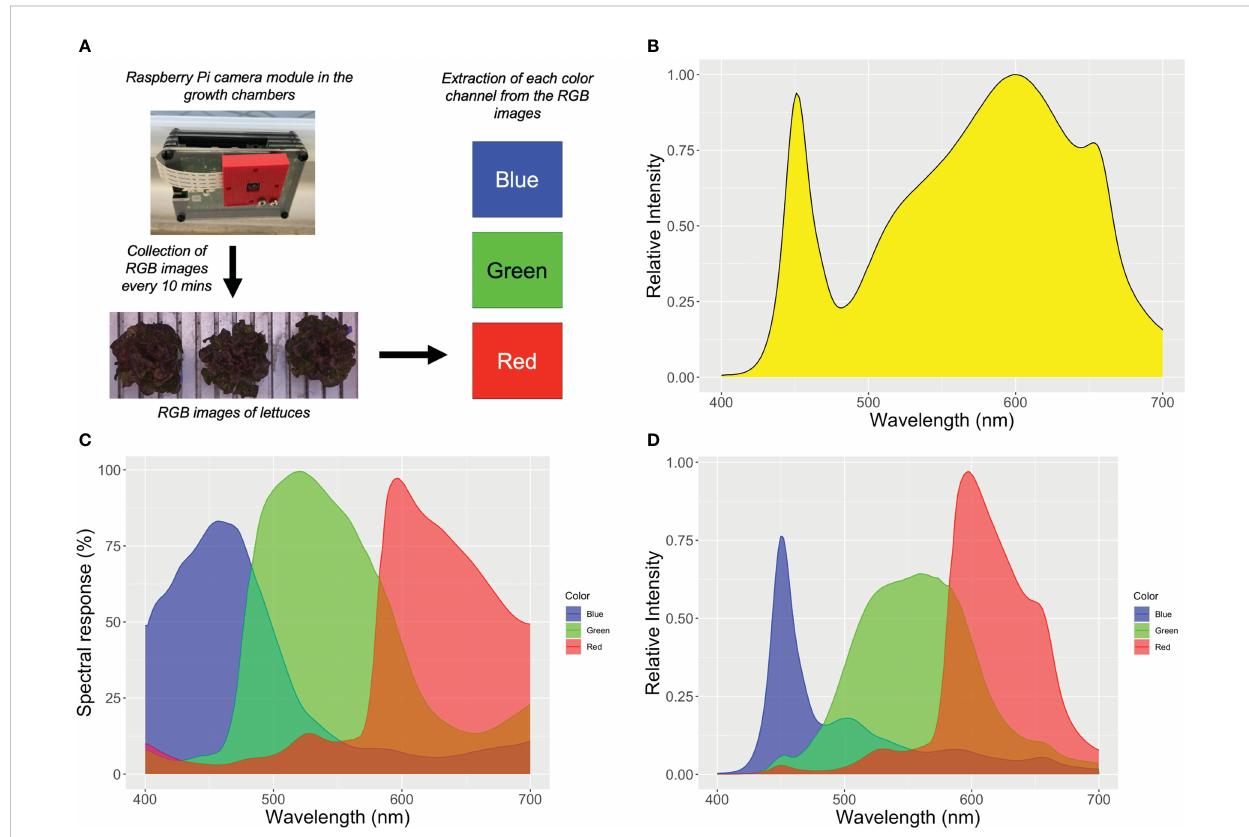
FIGURE 2 Schematic representation of acquisition process of green and red spectral images by the Raspberry Pi Camera Module V2.1 (A) , the normalized spectrum of the warm-white LED light fi xtures in the growth chambers (B) , the spectral sensitivity of the camera module (Pagnutti et al., 2017) (C) , and the combination of the spectral sensitivity of the camera and the light spectrum in the growth chambers, showing the spectral sensitivity during acquisition of each spectral image (D)